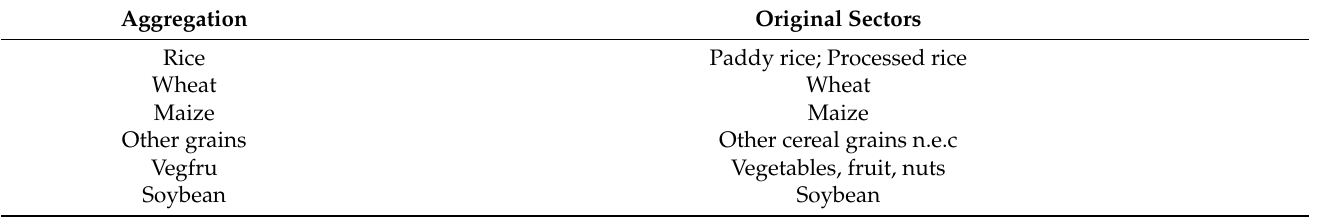
Table A1. Sectoral aggregation of the GTAP